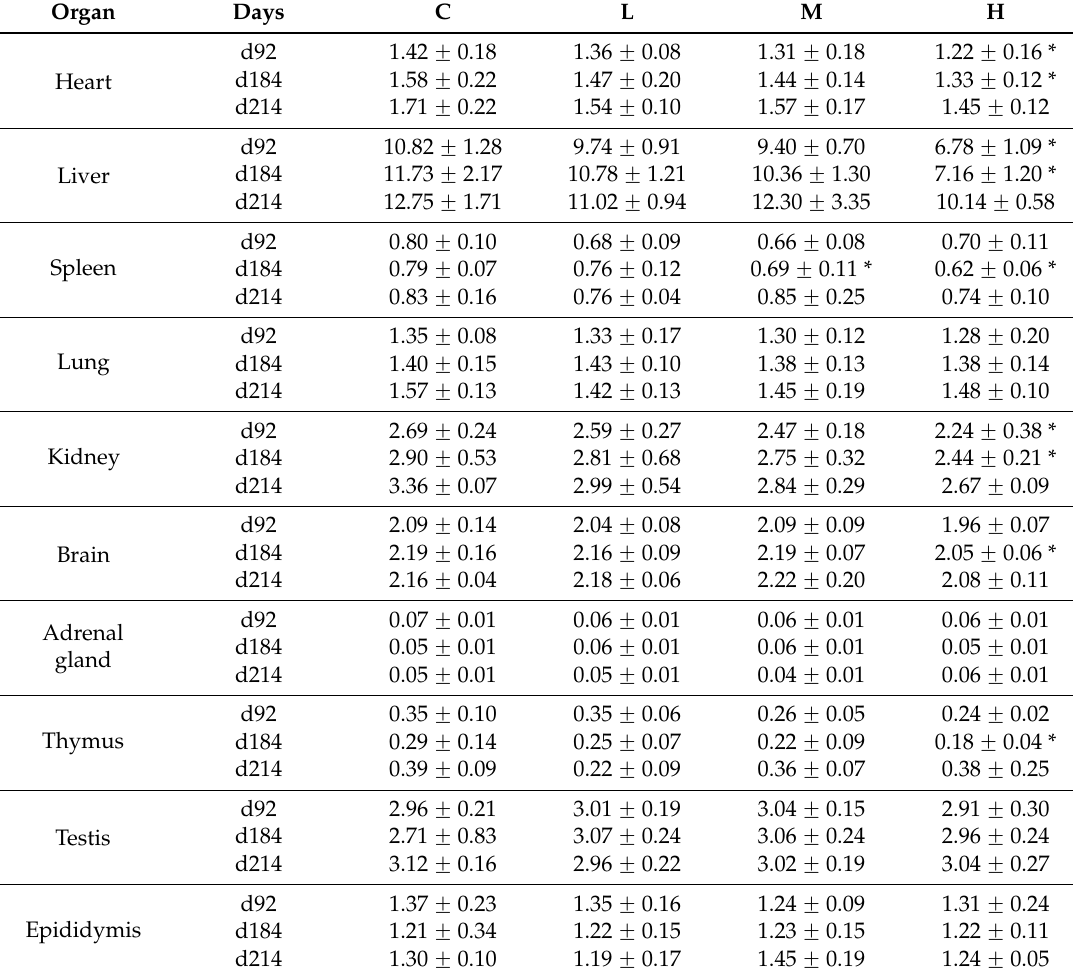
– x ˘ SD, d92 n = 5, d184 n = 10, d214 n = 5).